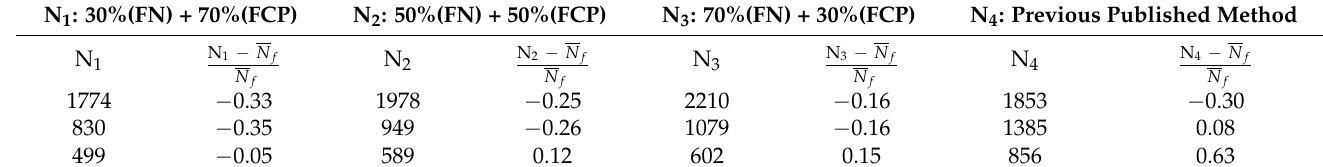
Figure 17. Comparisons between the experiments, predicted results using the proposed method under different probability combinations, and the method based on the crystal plasticity (CP) the- ory.